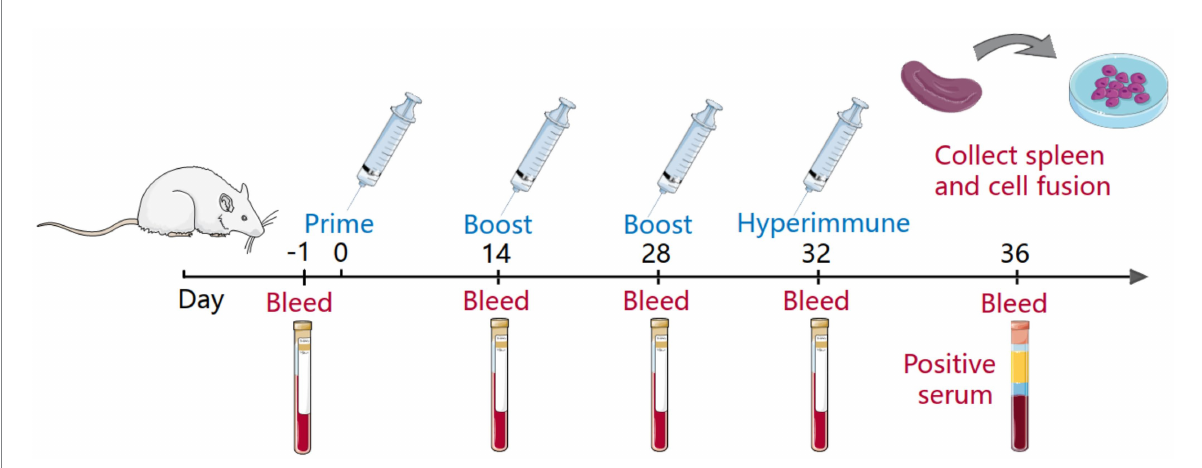
FIGURE 1 Immunity of mice and fusion of cells. The mice blood was collected as a negative serum before the primary immunization of the mice, and the serum titer was determined before each subsequent immunization. The immunity cycle of the mice was 21 days, and the mice underwent four immunizations, one primary immunization, two booster immunizations and a hyperimmunization before cell fusion. In addition, the serum before hyperimmunization was collected as positive serum.